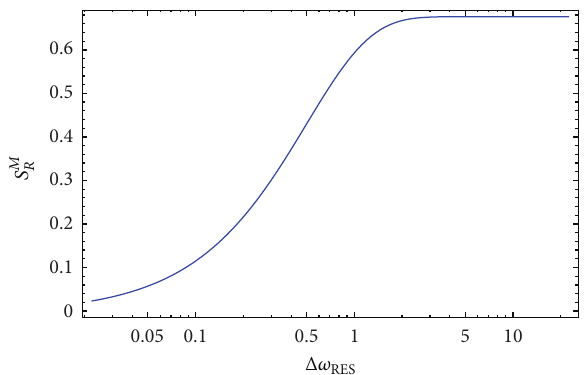
Figure 1: 𝑆 𝑀 𝑅 as a function of the logarithm of the instrumental resolution; the inflection point of the increasing sigmoid trend can be connected with the system relaxation